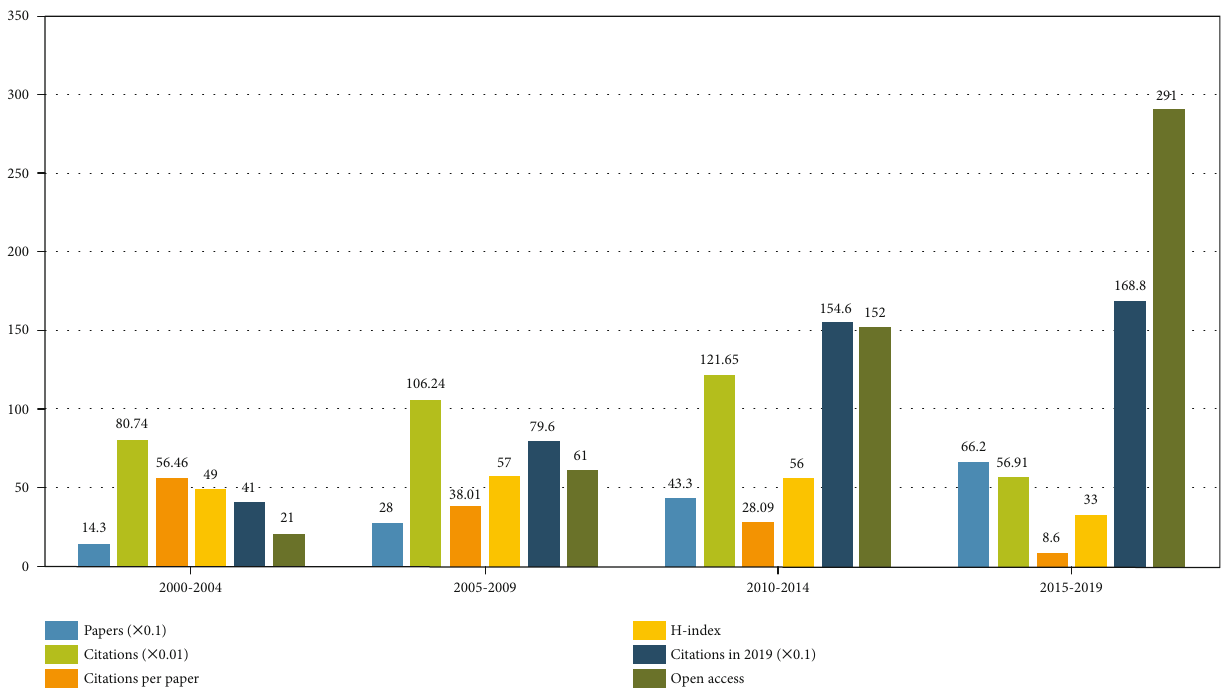
Figure 2: Number of papers, citations, citations per paper, open access paper, H -index, and citations in 2019 for each 5-year time